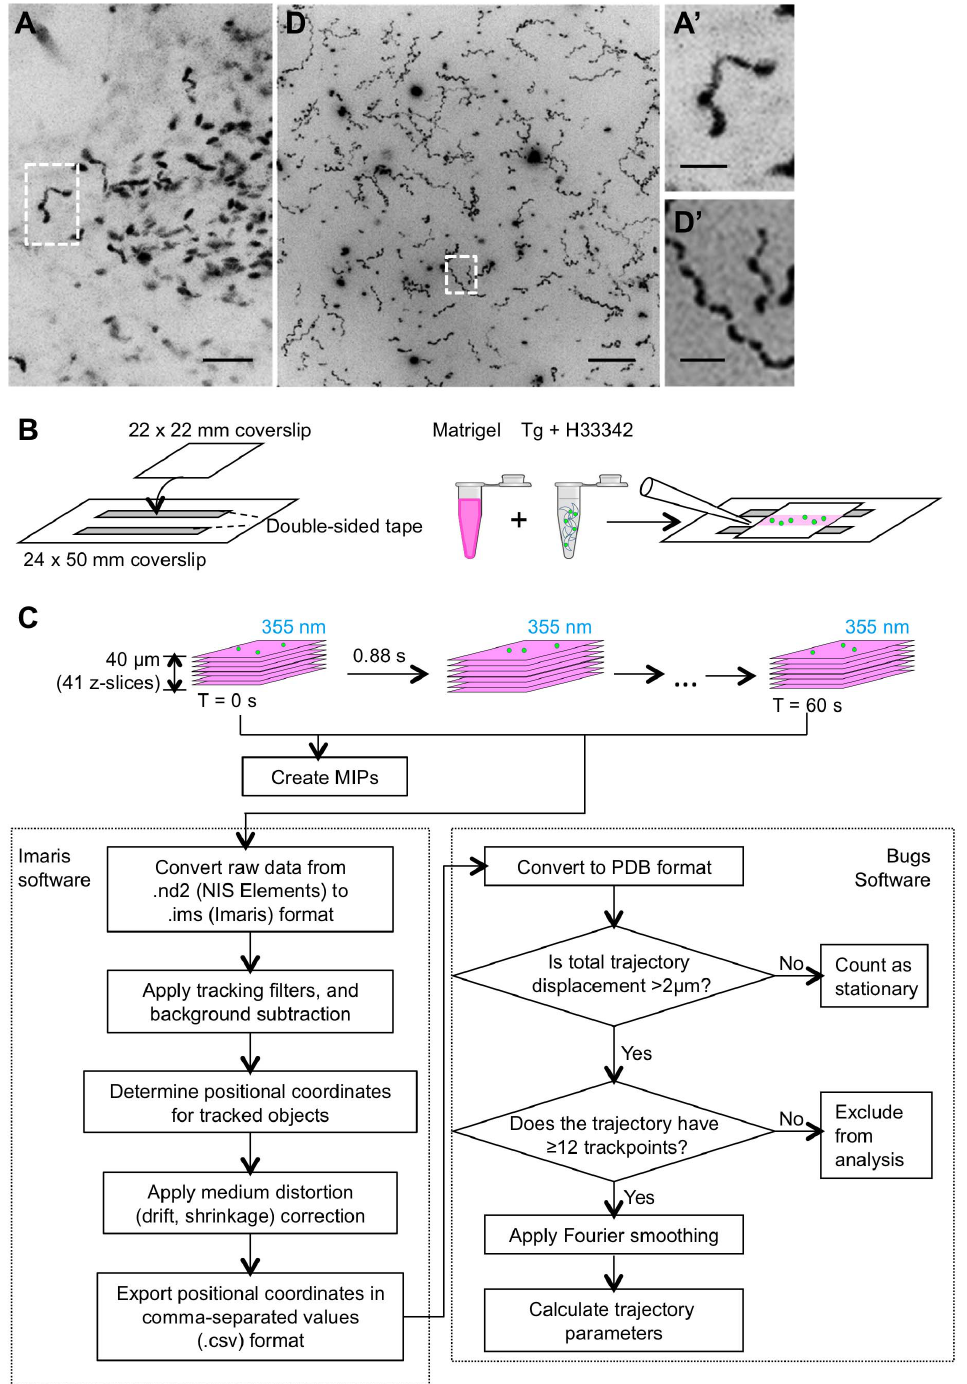
Figure 1. T.gondii moves in a corkscrew-like manner in three dimensions. ( A ) RH strain T. gondii tachyzoites expressing a tandem tomato fluorescence cassette (RH-OVA-tdTomato) were injected into a mouse earflap and imaged by two-photon laser scanning microscopy. A maximum intensity projection (MIP) shows parasites that move in a corkscrew-like fashion ( e.g. , dashed white box). Scale bar=29 m m. See Video S1 for the corresponding movie. ( A’ ) Higher magnification view of dashed white box in (A); scale bar=12 m m. ( B ) Assembly and dimensions of the imaging (‘‘Pitta’’) chamber. Coverslips were assembled using double-sided tape, and perfused with a 1:3:3 mixture of parasites treated with Hoechst 33342, 3D motility media and chilled Matrigel, respectively. ( C ) Pitta chambers were incubated at 27 u C for 7 min, followed by 2 min equilibration in the preheated 35 u C microscope enclosure. Fluorescent parasite nuclei were imaged for 60 s in a 402 m m 6 401 m m 6 40 m m volume (approximately 67 z- stacks, with 41 z-slices captured every 0.88 s) by time-lapse fluorescence videomicroscopy. Datasets were visualized during acquisition by generating MIPs, tracked using the Imaris software, and then analyzed using the Bugs software as indicated in the workflow. ( D ) A MIP showing that parasites also move in corkscrew-like trajectories in Matrigel. Scale bar=50 m m. See Video S3 for the corresponding movie. ( D’ ) Higher magnification view of dashed white box in (D); scale bar=10 m m. The colour scheme for all MIPs was inverted for better visualization of parasite trajectories. doi:10.1371/journal.pone.0085763.g001 PLOS ONE | www.plosone.org